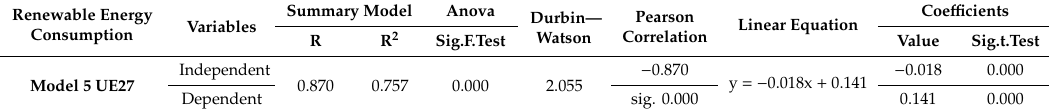
Figure 5. β -convergence renewable energy consumption in UE27 1990–2014 (Model 5). Table 5. Results of econometric model for β -convergence of renewable energy consumption.